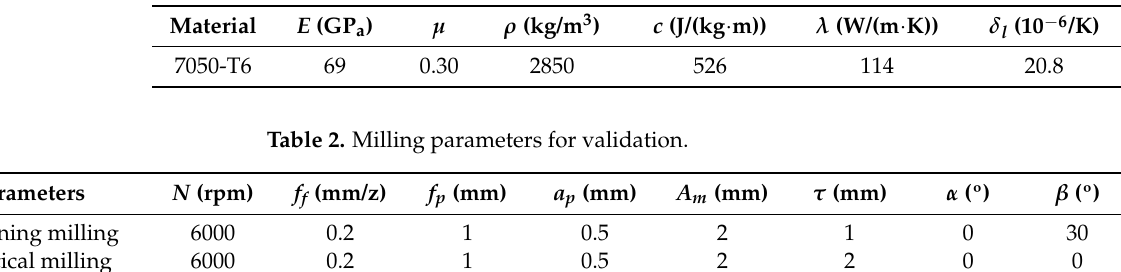
Table 1. Characteristics of the 7050-T6.